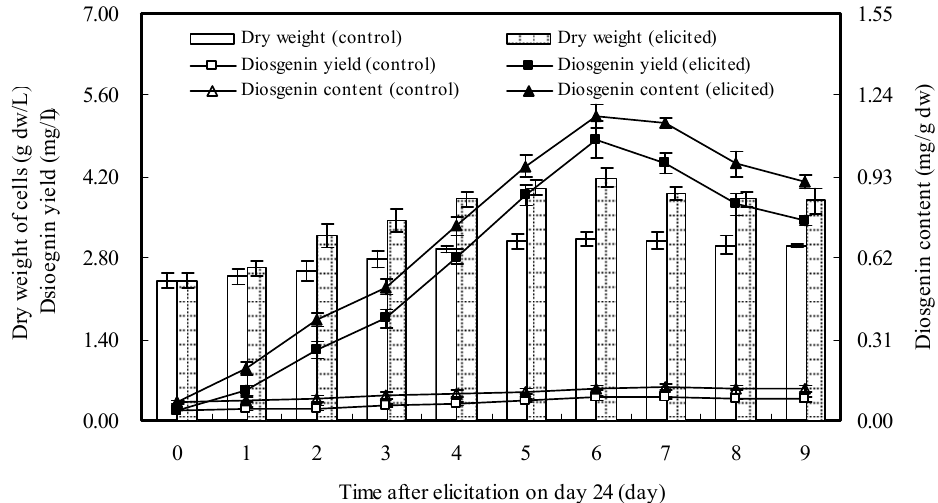
Figure 4. Time courses of growth and diosgenin accumulation of D. zingiberensis cell cultures treated twice with DP7 added on days 24 and 26 at 6 mg/L. The error bars represent standard deviations ( n =